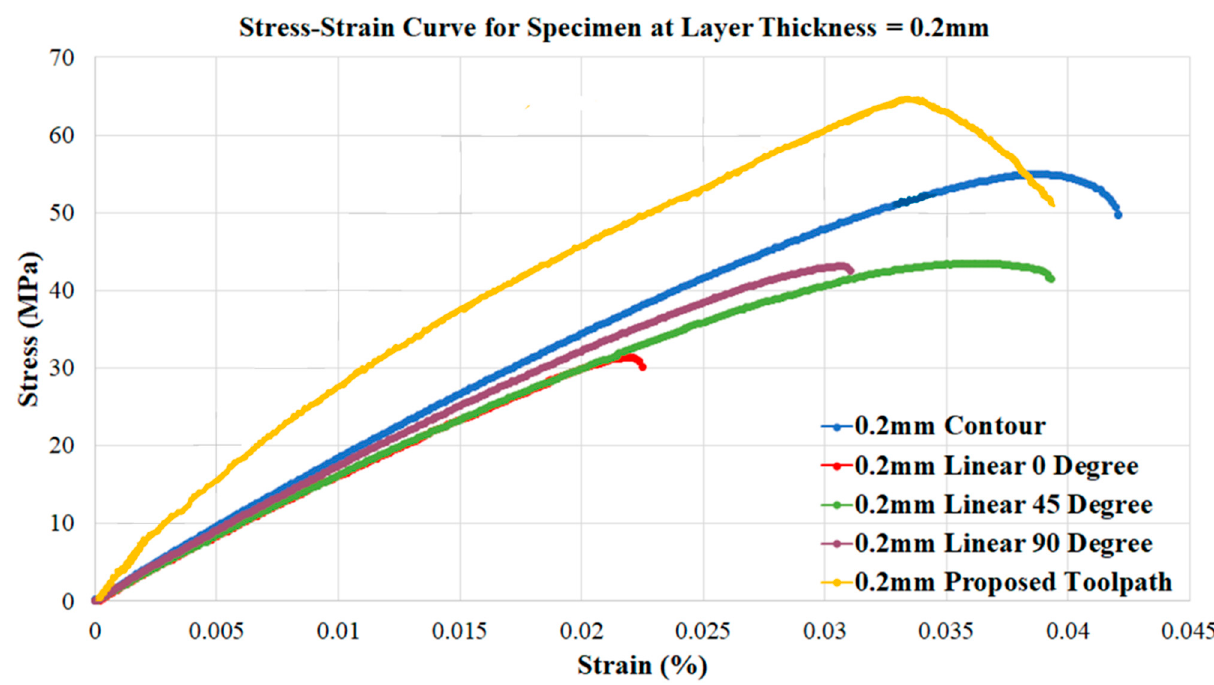
Figure 9. Load extension graph for all print specimens at layer thickness = 0.2mm.